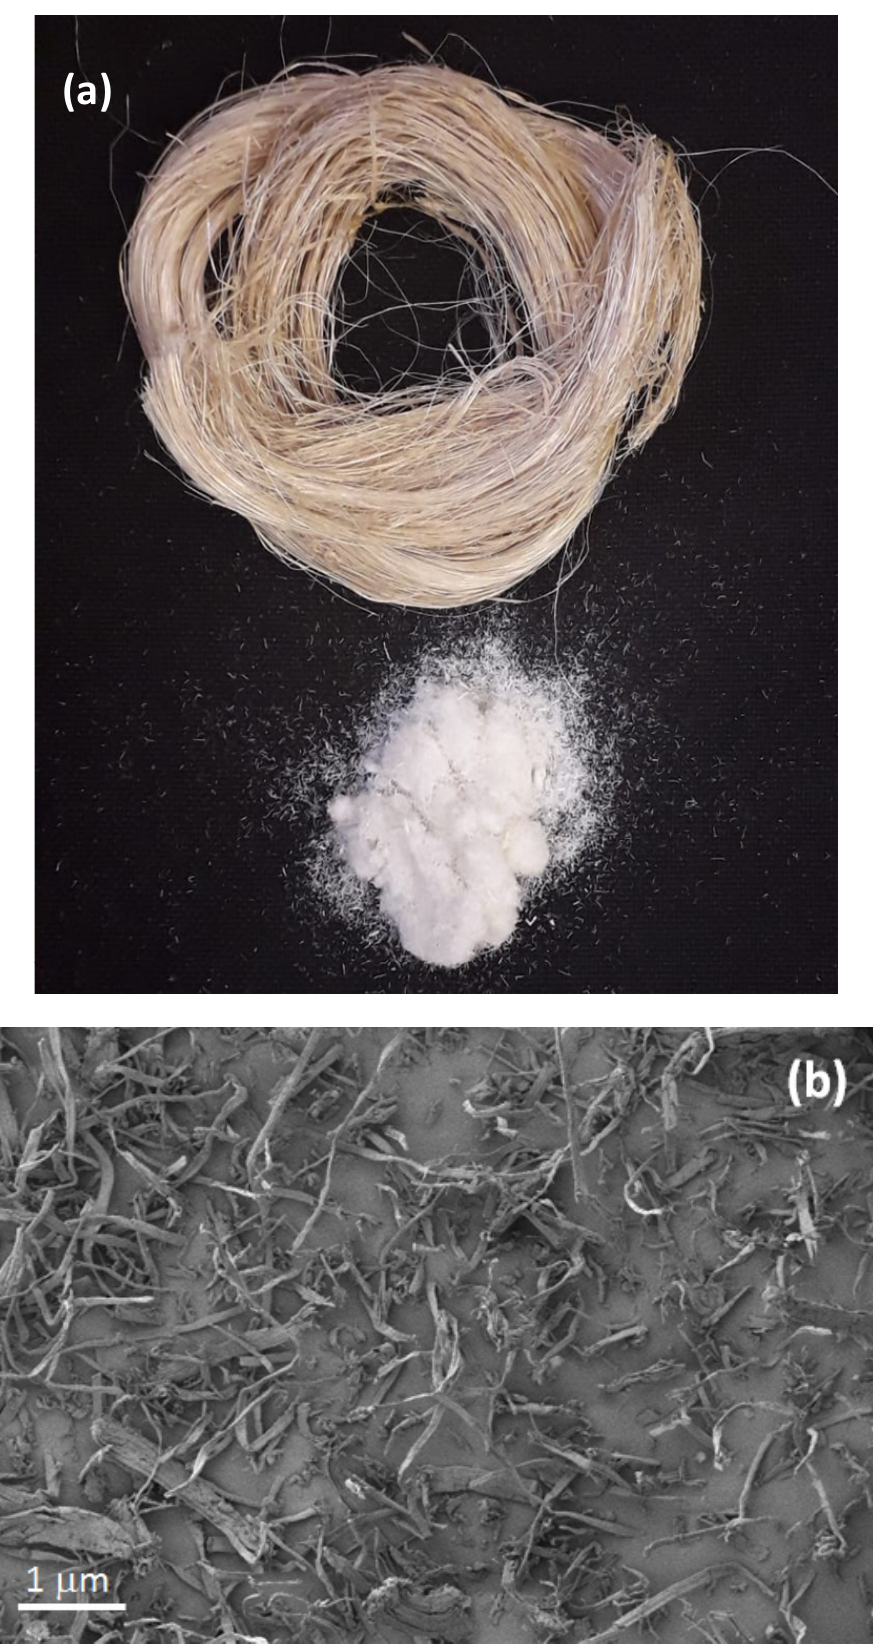
Figure 1. Fiber and cellulose nanofiber (CNF) images shows ( a ) photography image of raw banana fiber and extracted CNF; ( b ) SEM image of CNF fibrils.